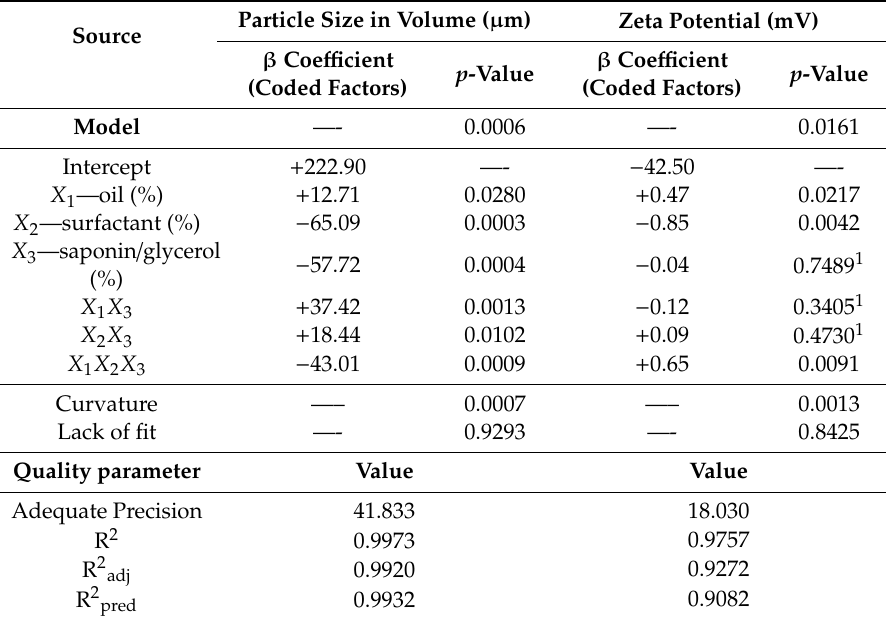
Table 3. Regression parameters ( β coe ffi cients) of the optimal multiple linear regression models (MLRMs) established for the particle size in volume ( µ m) and zeta potential (mV) using a stepwise variable selection method for the 2 3 experimental design and respective model quality